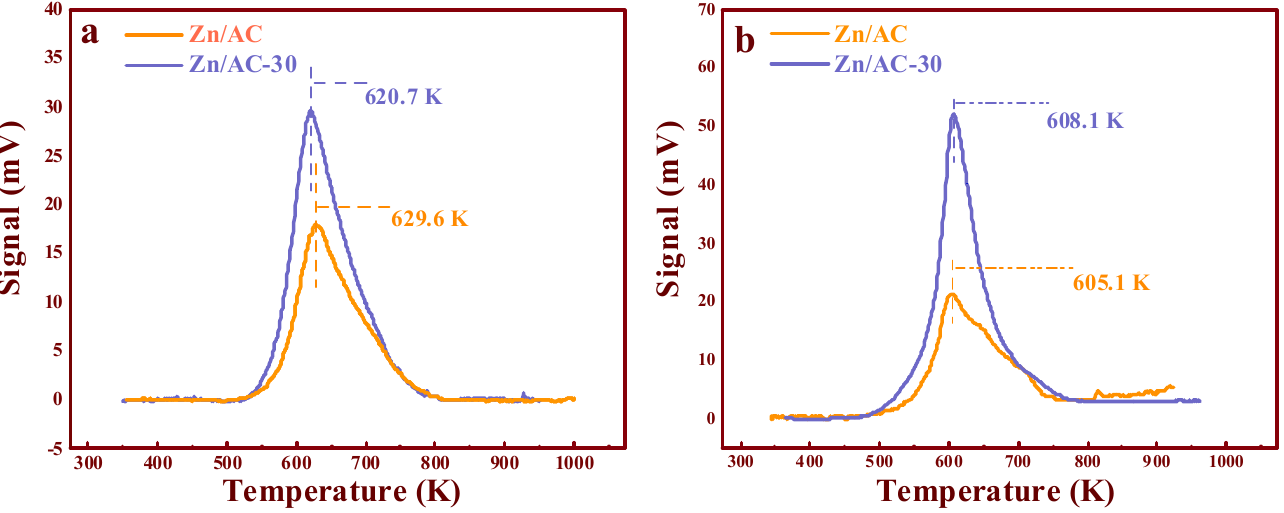
Figure 7. TPD analysis of different reactants: ( a ) C 2 H 2 and ( b ) CH 3 COOH.